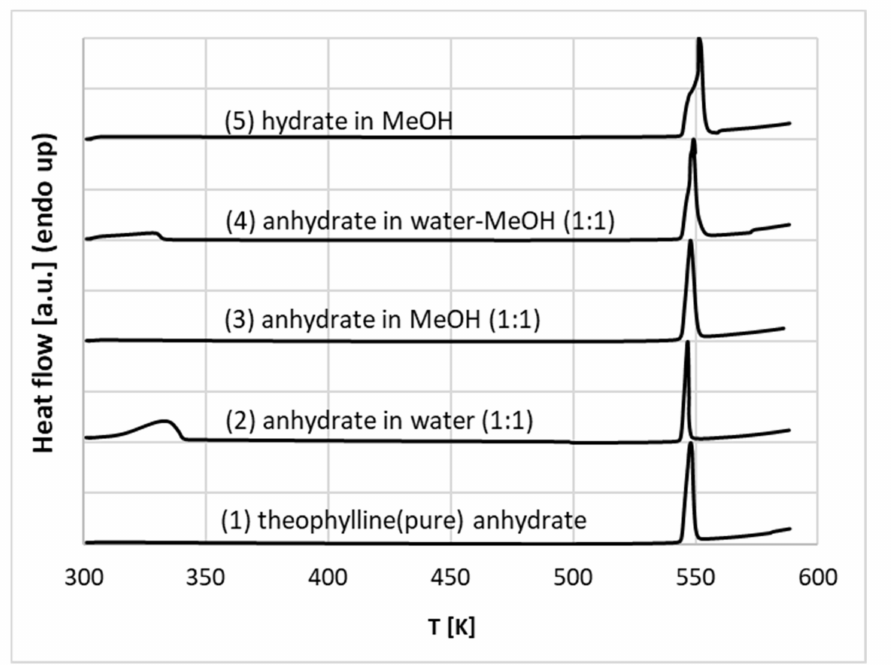
Figure 5. Thermograms of the products of milling of pure commercial anhydrated theophylline (1), anhydrate co-grinded with equimolar amounts of neat water (2), neat methanol (3), aqueous unimolar mixture with methanol (4) and monohydrate co-grinded with methanol